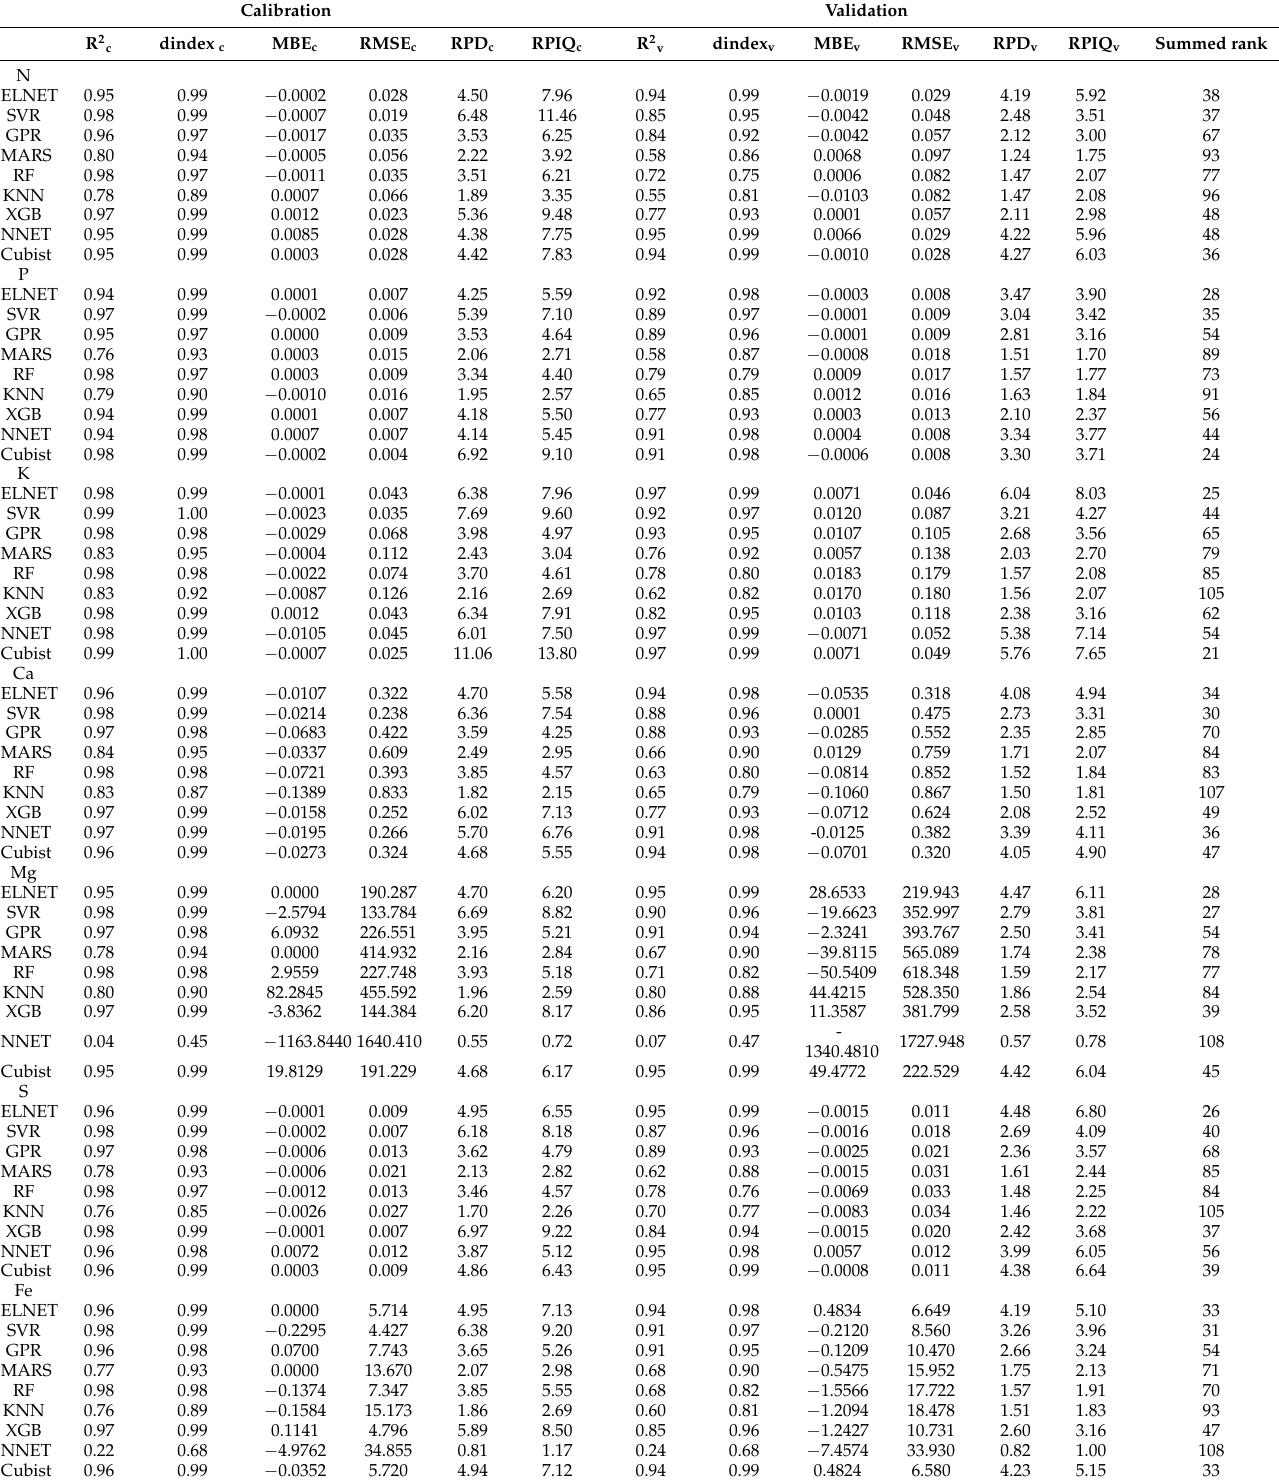
Table A1. Performance of the PLSR-combined machine learning models for calibration and validation to predict the nutrients content mango